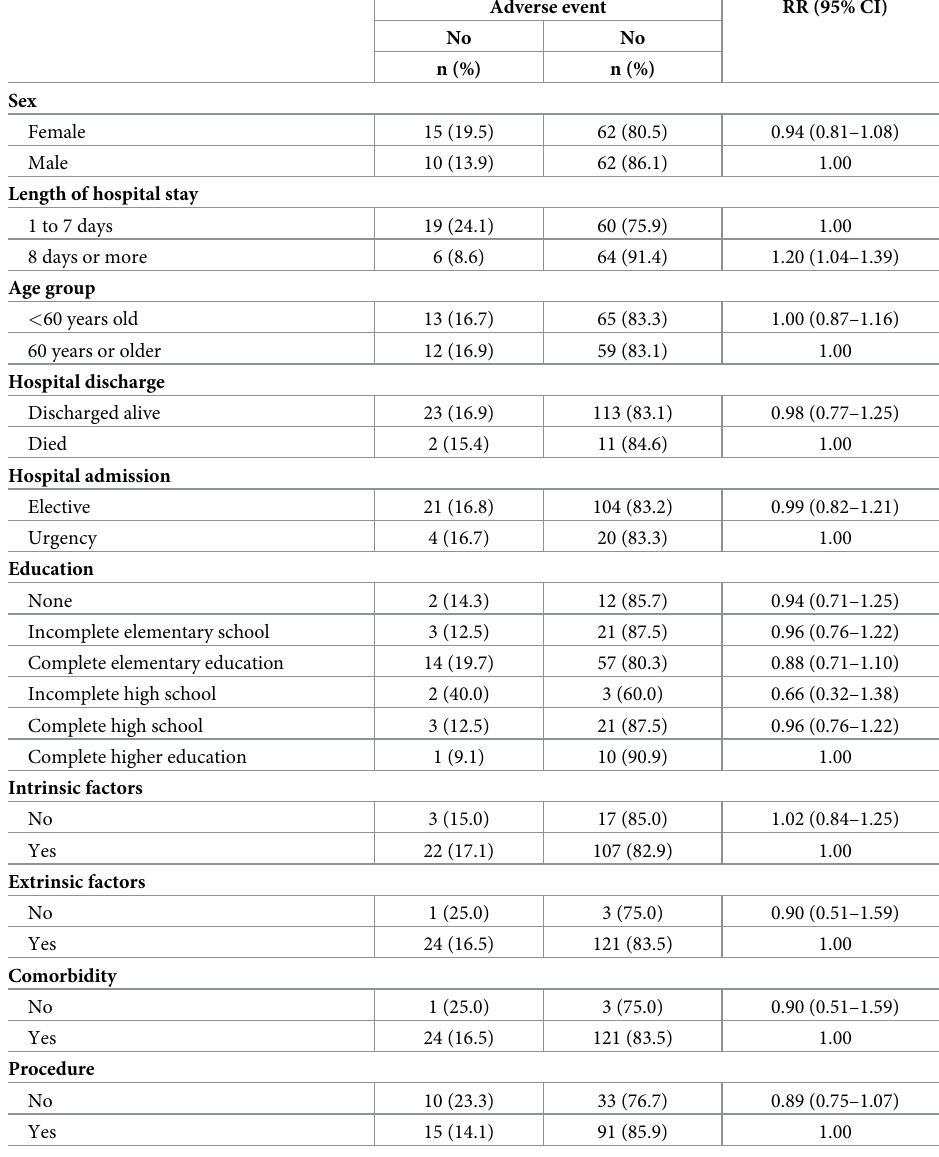
Table 5. Risk factors for the occurrence of adverse